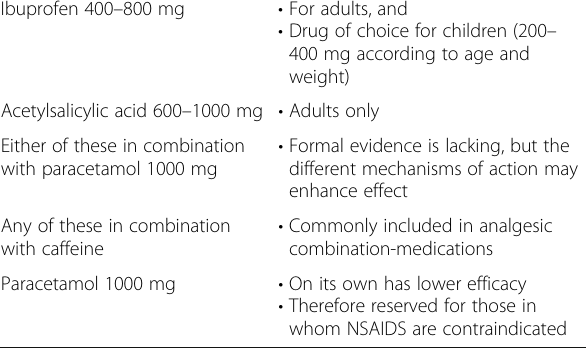
Table 11 Analgesics for episodic tension-type